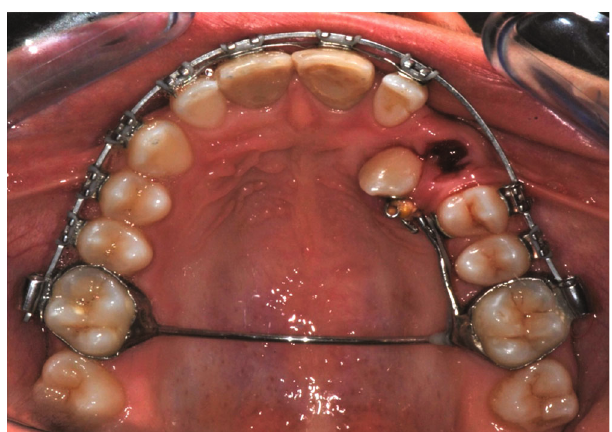
Figure 7: Position of 2.3 after 3 months of orthodontic traction and the extraction of deciduous